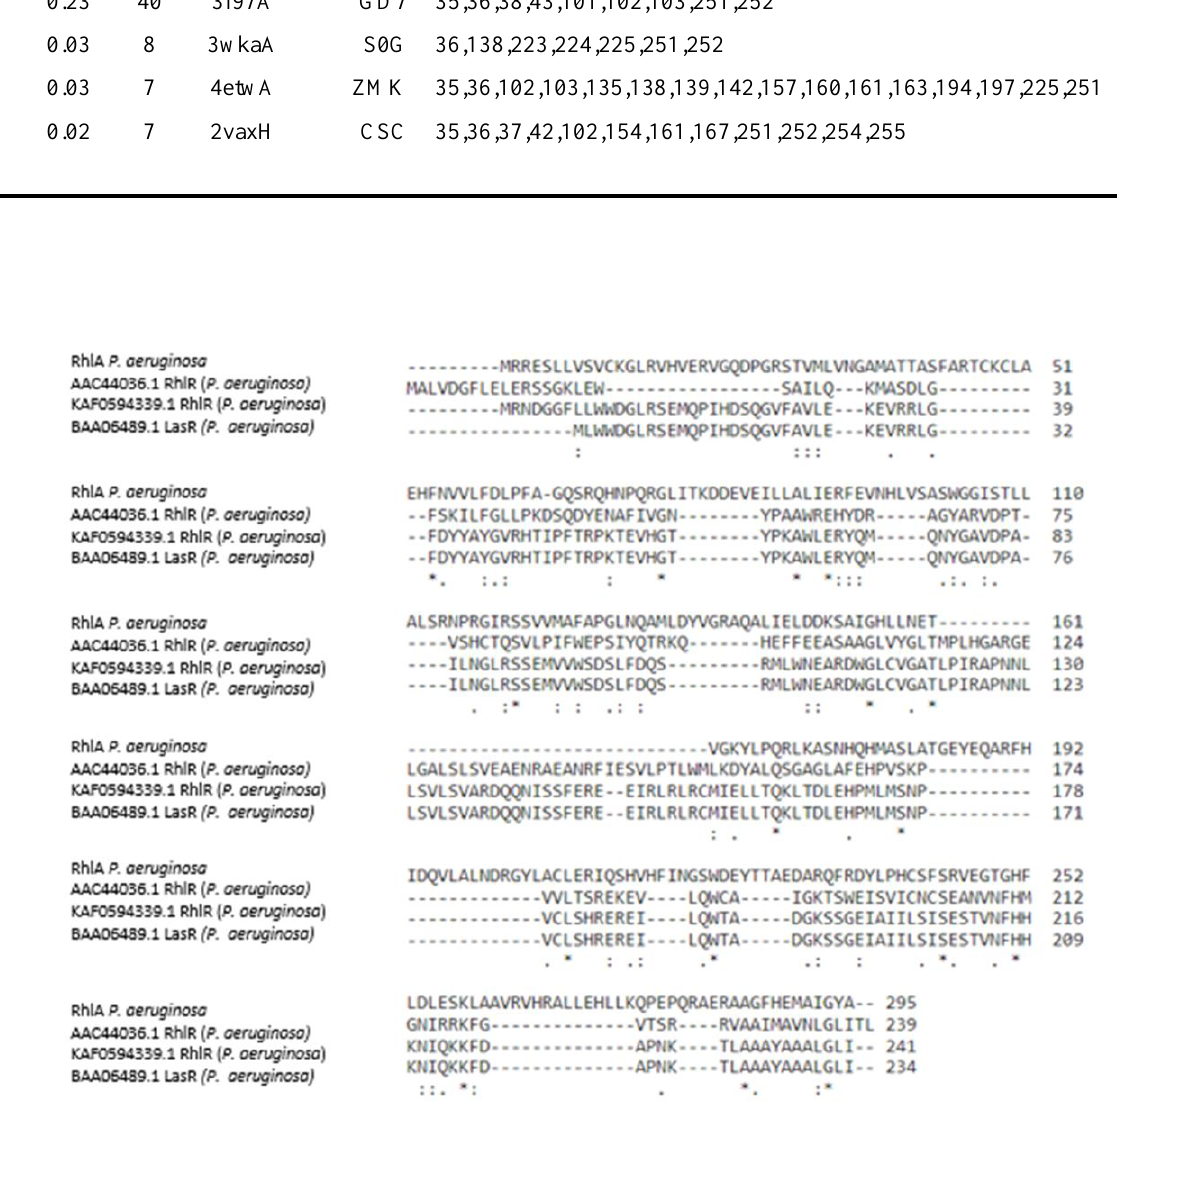
Fig. 3 . Alignment of the amino acid sequence of RhlA (Accession code= WP_003113897.1) with LuxR proteins: transcriptional regulator RhlR of P. aeruginosa PAO1 (accession code= AAC44036.1), RhlR of P. aeruginosa (accession code= KAF0594339.1) and with transcriptional regulator LasR of P. aeruginosa (accession code= BAA06489.1) using Clustal